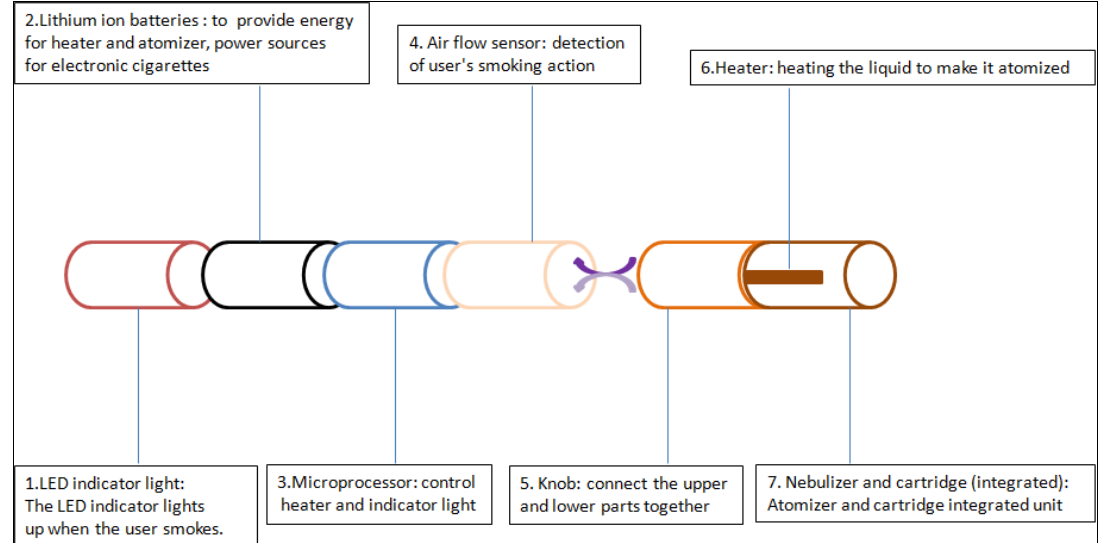
Figure 1. Diagram of electronic cigarette design.